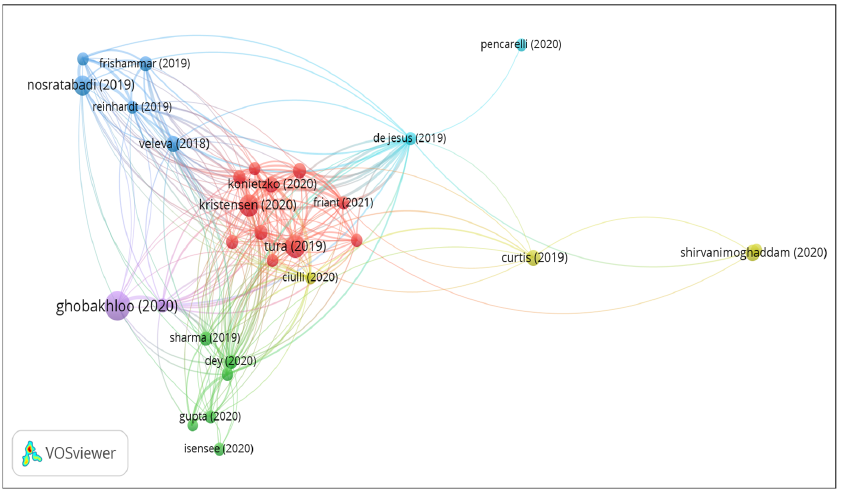
Figure 12. VOSviewer diagram containing the most cited papers (with at least 50 citations) for the couple: social innovation and circular*. couple: social innovation and circular*